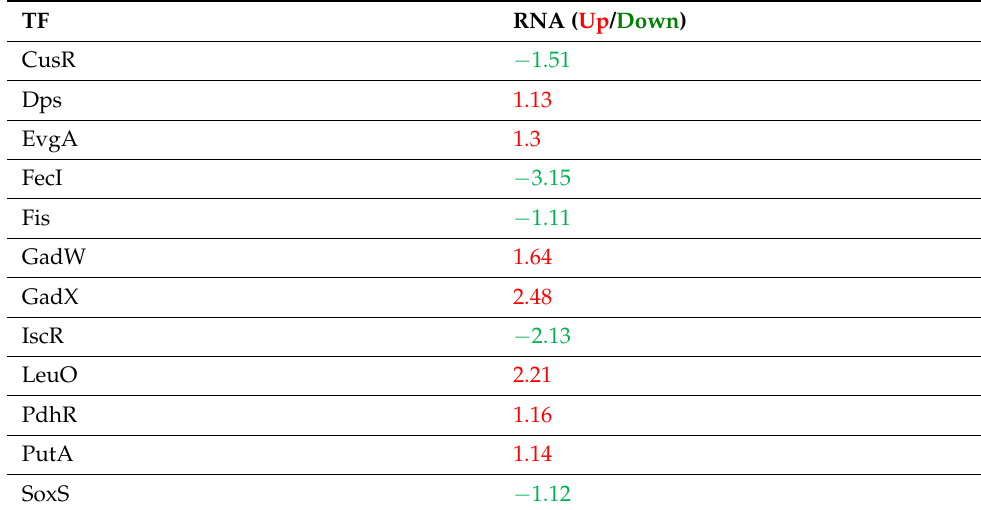
Table 3. Higher differential expression of mRNA coding for E. coli transcription factors (TF).